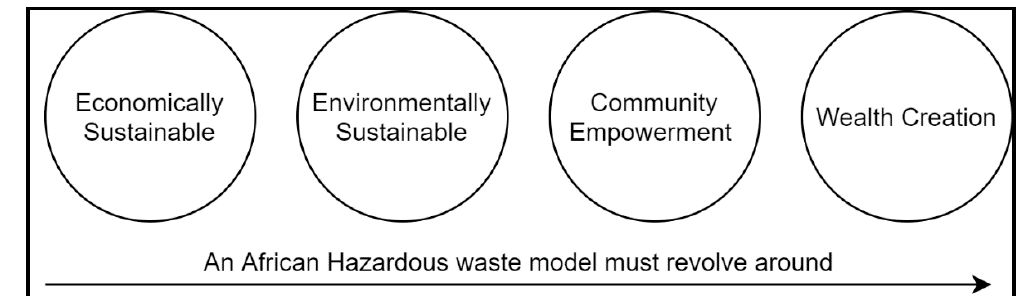
Figure 11. Critical issues that an African hazardous waste management model must tackle.